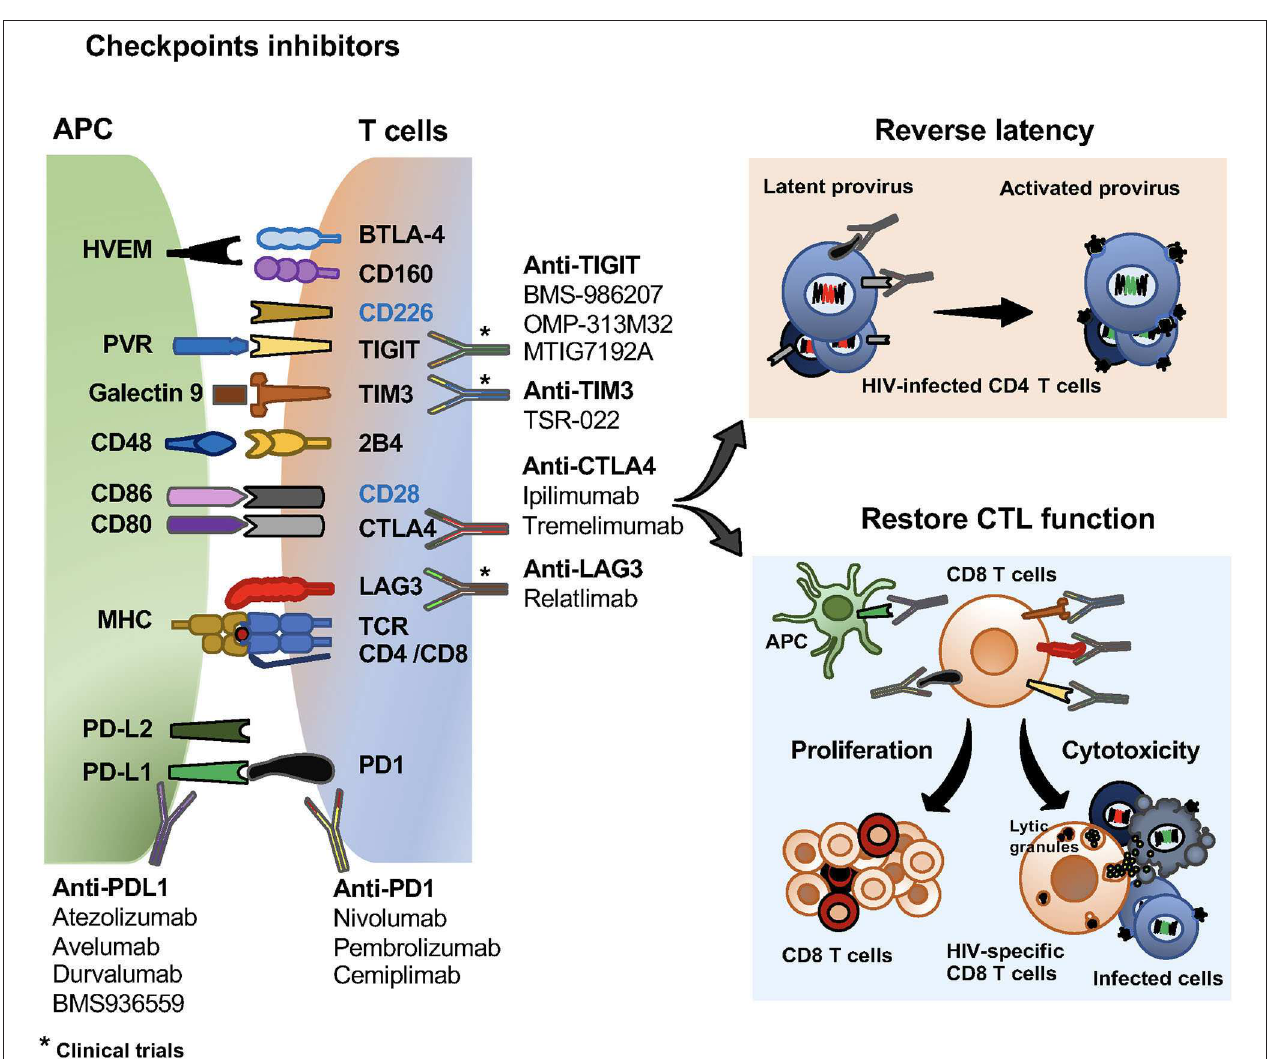
FIGURE 2 | Checkpoint inhibitors and their effects on HIV specific T cells and the viral reservoir. Checkpoint inhibitors in clinical trials for the treatment of malignancies and HIV infection. Monoclonal antibodies blocking PD1, PD-L1, CTLA4, LAG3, TIGIT and TIM3 currently use in clinical trials. Effects of checkpoint receptors in reversing latency of the viral reservoir, and restoring CD8T cell proliferation and cytotoxic functions.